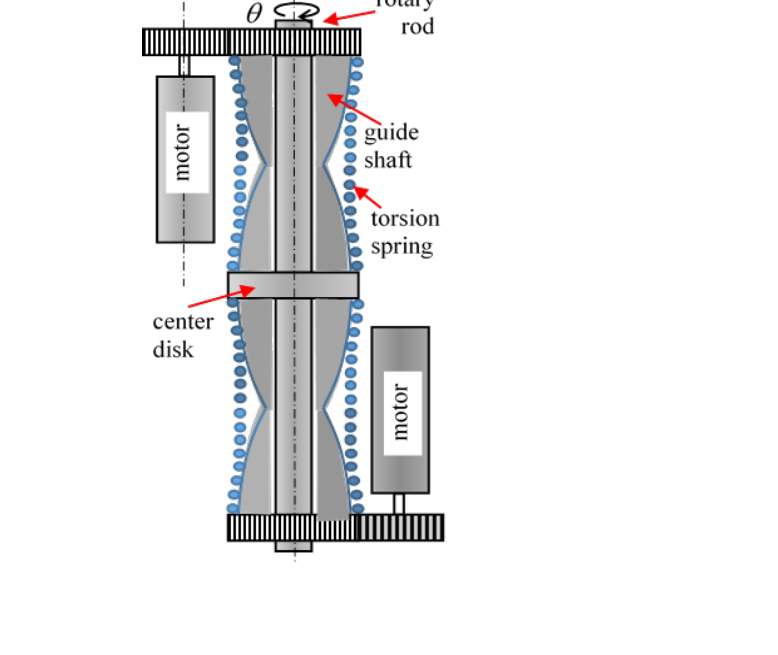
Figure7. Rotary joint controlled by a pair of r-